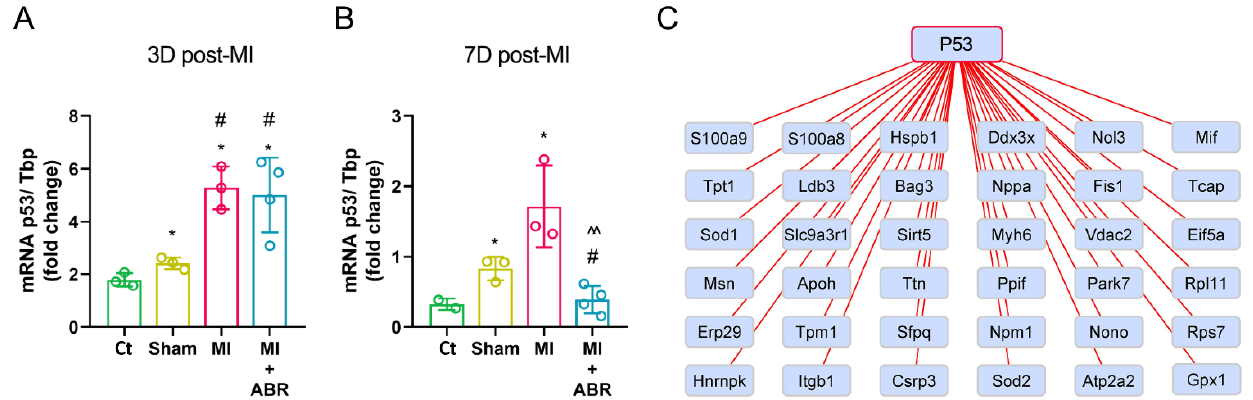
Figure 6. Effect of S100A9 blockade on p53 in the LV post-MI. mRNA expression levels of cellular tumor antigen P53 (P53) in the LV of unoperated control Ct, Sham, MI and MI + ABR groups quantified by real-time PCR using Tbp (TATA sequence binding protein) as internal control, at 3 ( A ) and 7 ( B ) days post-MI. Interactions of p53 with DEPs implicated in leukocyte cell–cell adhesion, regulation of the muscle cell apoptotic process, regulation of the intrinsic apoptotic signaling pathway, sarcomere organization and cardiac muscle hypertrophy GO biological processes ( C ). The proteins (identified by gene name) are represented as rectangle nodes. Data are presented as mean ± SD; * p < 0.05 vs. Ct; # p < 0.05 vs. Sham; ^^ p < 0.01 vs. MI; p values were calculated using Student’s t test.